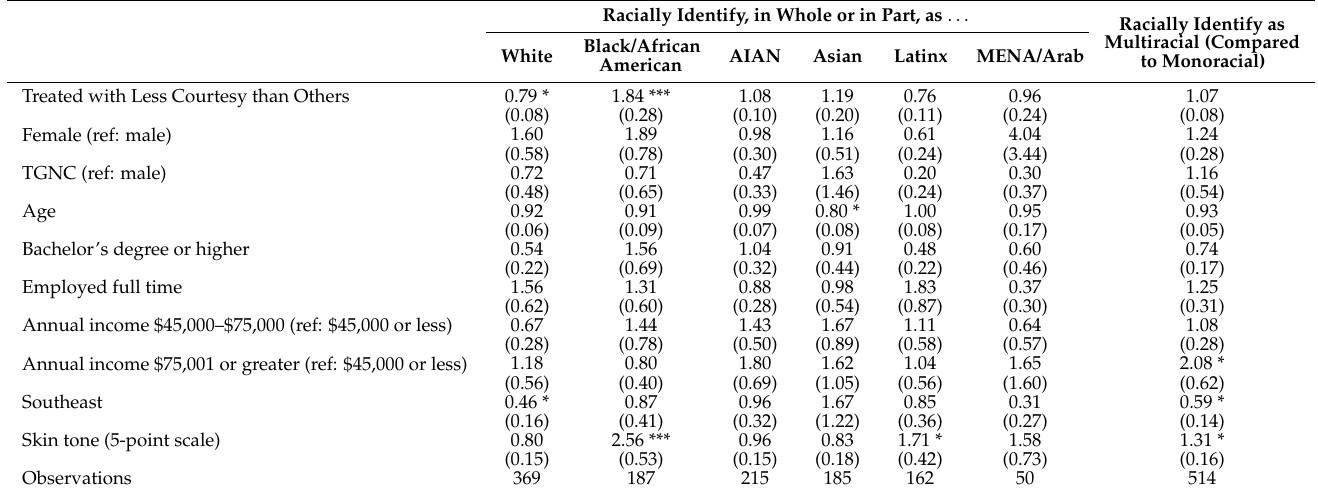
Table A1. Sensitivity Test—Odds Ratios of Being Treated with Less Courtesy due to Race/Ethnicity predicting Racial